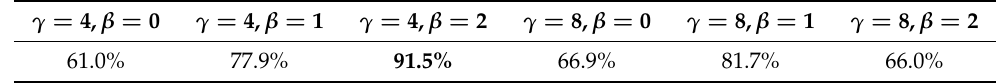
Table 2. The accuracy of different normalized parameters with LeakyReLU(0.5).